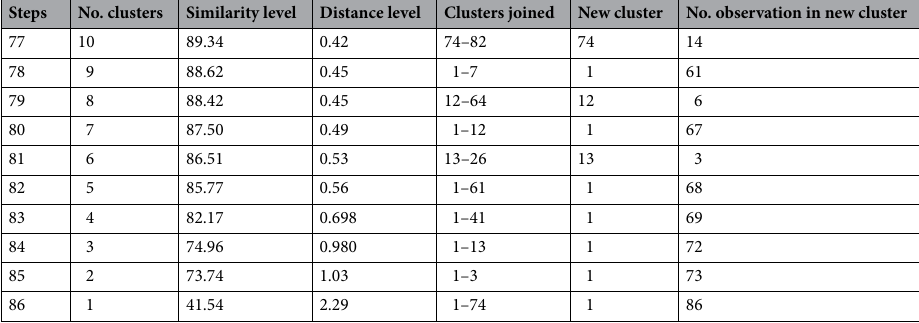
Table 4. Number of morphological clusters, similarity and distance levels of T. graeca across the study area.